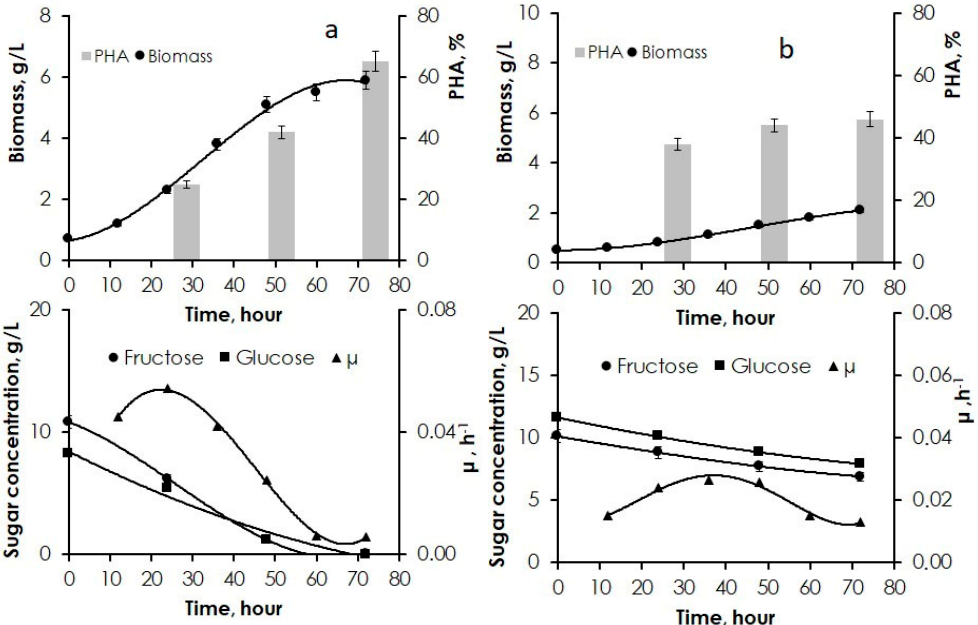
Figure 3. Parameters of cell growth and PHA synthesis achieved by C. necator B-10646 cultivated on JA vegetative biomass hydrolysates (growth curve, PHA content, consumption of carbohydrate substrates, specific growth rate): ( a ) aqueous extraction at 80 °C followed by acid hydrolysis at 60 °C, ( b ) simultaneous extraction and acid hydrolysis at 80 °C.